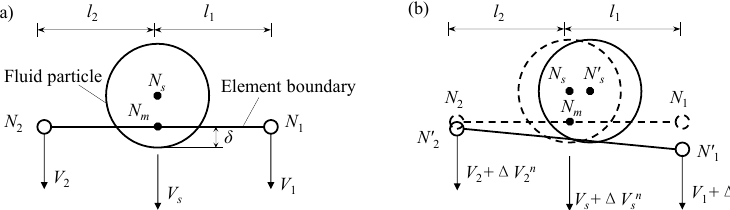
Figure 1. Contact treatment between fluid and structure: ( a ) before adjustment; ( b ) after final iteration.